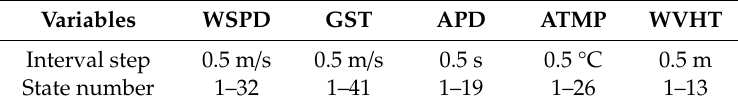
Table 4. Discretization standard of variables.